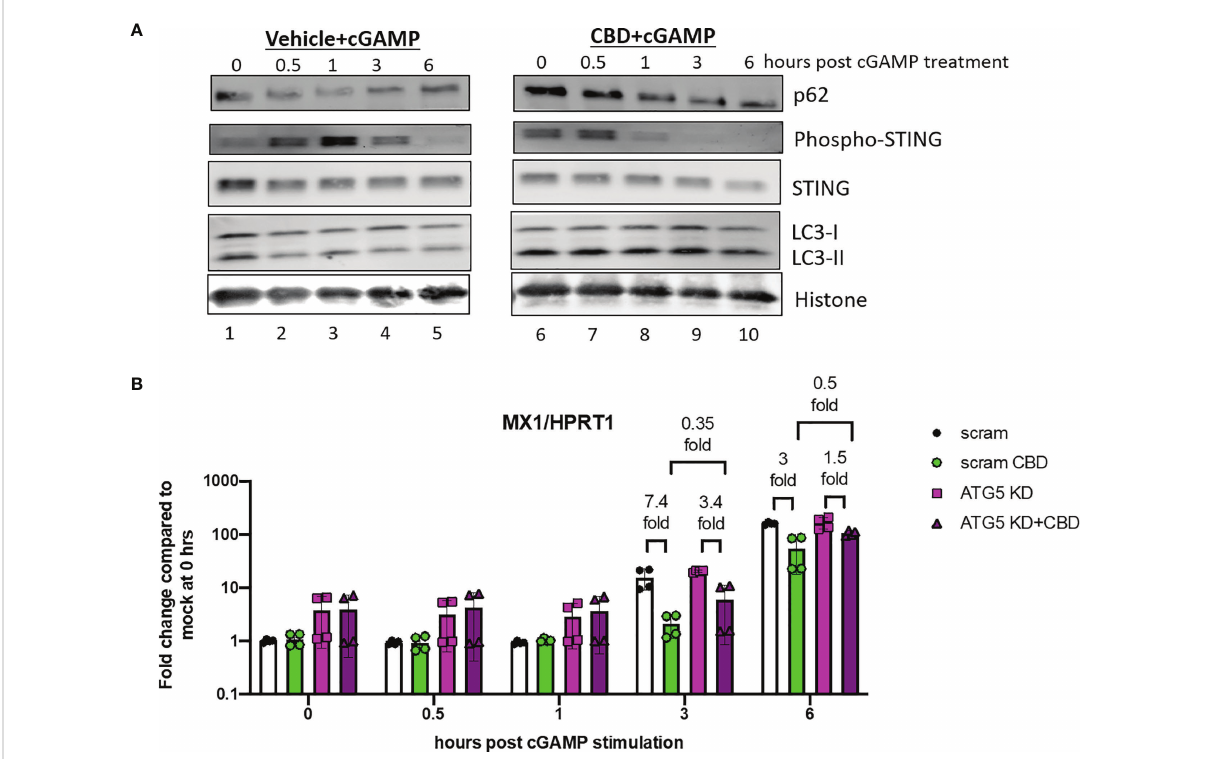
FIGURE 4 CBD leads to rapid down regulation of phosphor-STING expression after 2 ’ 3 ’ -cGAMP stimulation. (A) Western blot analysis of THP-1 cells that were treated with either vehicle or CBD, followed by 2 ’ 3-cGAMP stimulation. Cells were harvested at 0, 0.5, 1, 3, 6 hours post stimulation. The expression of autophagy markers (p62/LC3-II), STING and phospho-STING, and histone protein control in vehicle (lane 1-5) and CBD treated (lane 6-10) cells were analyzed. (B) THP-1 cells were transduced with either CRISPR/Cas9 system with either scramble or ATG5 targeting guide RNA. Afterwards, cells were treated with either vehicle or CBD, followed by 2 ’ 3 ’ -cGAMP stimulation. Cells were harvested at 0, 0.5, 1, 3, 6 hours post stimulation and MX1/HPRT1 expression was measured by real time